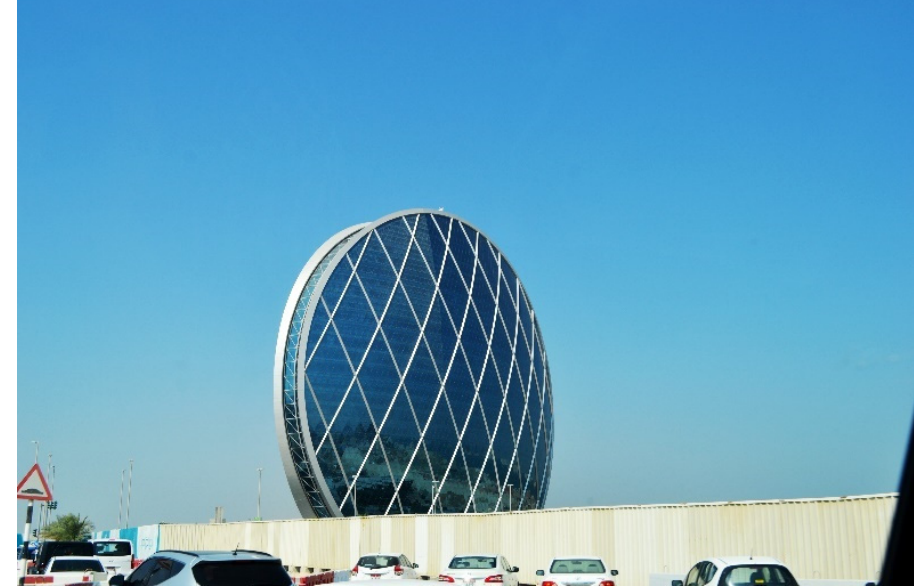
Figure 16. Al Dar Headquarters (2010) in Abu Dhabi, UAE. (Photo by K. Al-Kodmany).